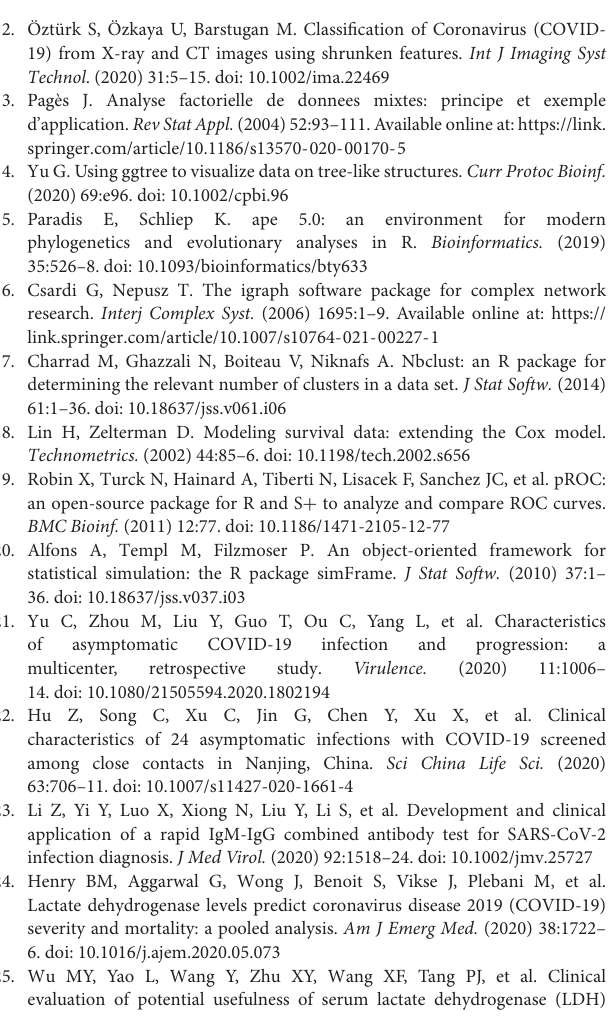
Supplementary Figure 6 | Performance of prediction model in the case of missing data. Dataset was randomly divided into 50% training and 50% missing tests datasets. Missing data were imputed by k -nearest neighbor (KNN) method. The line chart demonstrated the distribution of kappa statistic of support vector machine in the case of about 1% to 10 % missing data. Tests were repeated with 50 times with the same missing rate. The blue dashed line indicated the change trend of mean kappa statistics with different missing rate. Grey crosses indicated different kappa statistics obtained in different tests, and grey area represented the range of kappa statistics. Supplementary Table 1 | 53 independent variables (dimensions) extracted by Factor Analysis of Mixed Data. Supplementary Table 2 | Laboratory indicators and ages in Cluster A and B normal distribution test results. Supplementary Table 3 | Laboratory indicators and ages in Cluster A, B and C normal distribution test results. Supplementary Table 4 | Laboratory indicators and ages in Cluster A, B, C and D normal distribution test results. Supplementary Table 5 | Homogeneity of variance test results of albumin in two, three and four